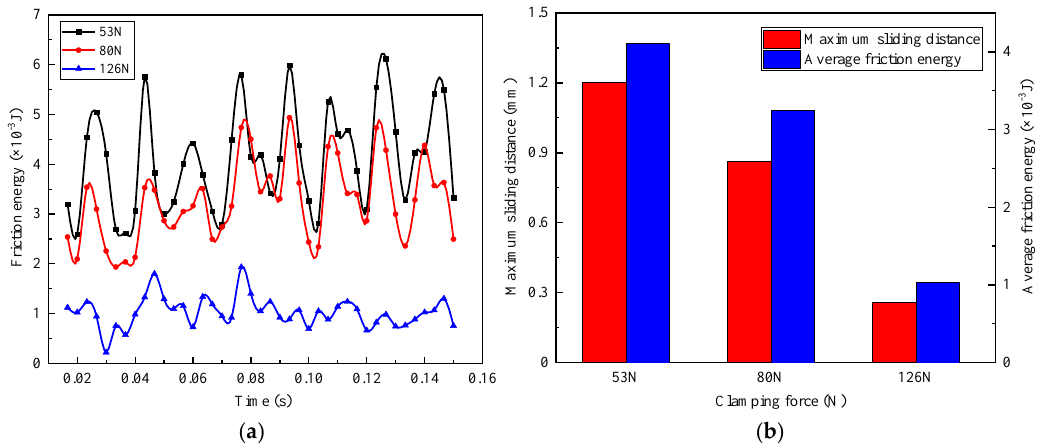
Figure 9. ( a ) Friction energy in each cycle; ( b ) Maximum sliding distance and average friction energy under different clamping forces.